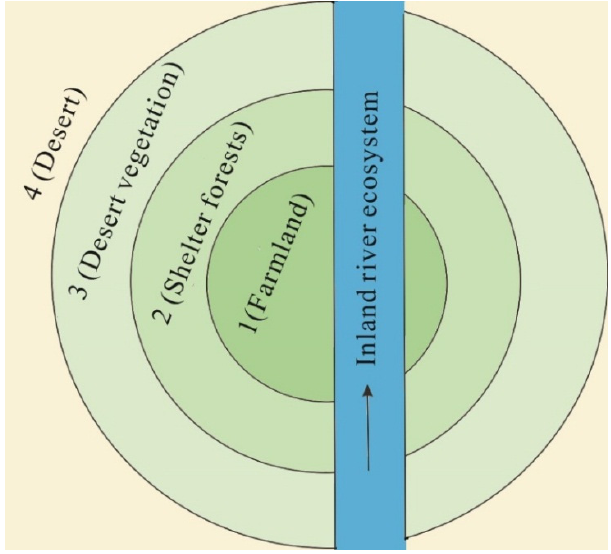
Figure 1. Schematic map of ecosystem functions in the oasis areas of Tarim